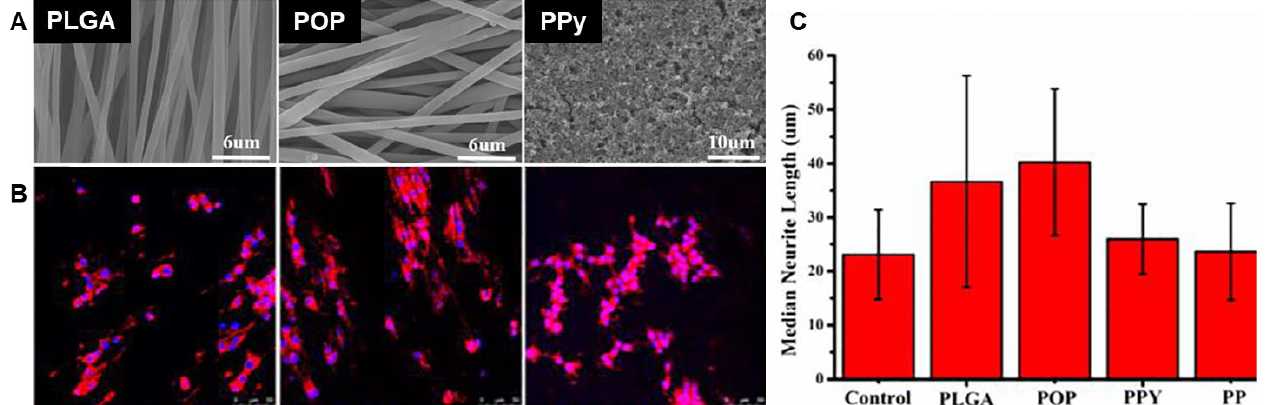
Figure 18. Nerve tissue scaffold application of electrospun CPs [256]. Left to right: electrospun PLGA, PPy-coated electrospun PLGA (labeled POP), and PPy film. ( A ) SEM images. ( B ) Laser scanning confocal microscopy images of PC12 cells grown on the electrospun and cast scaffolds, showing improved neurite proliferation and directional growth in PPy-coated electrospun PLGA. ( C ) Comparison of the median neurite lengths of PC12 cells grown on polymer scaffolds, showing the best neurite growth for PPy-coated electrospun PLGA (labeled POP). Reprinted with permission from Ref. [256], Copyright 2018, with permission from Elsevier.